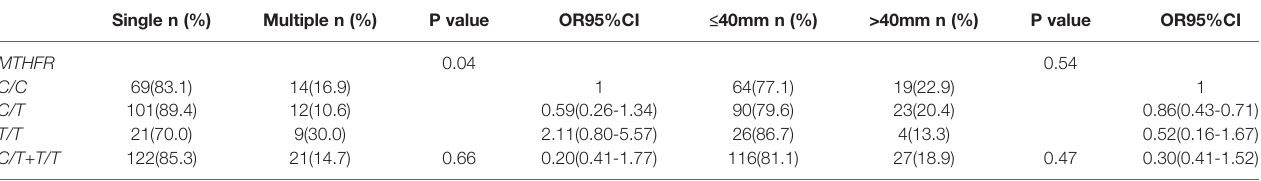
TABLE 3 | Correlation analysis between MTHFR C677T polymorphism and the size and number in the case group. Single n (%)